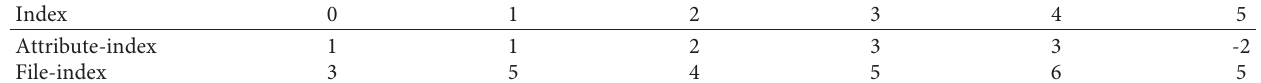
Table 2: Example of the ADLinks array.